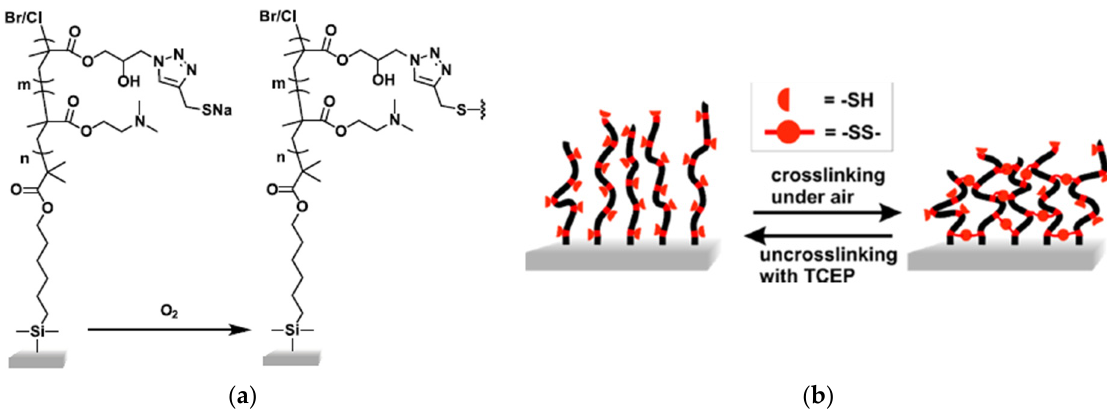
Figure 17. ( a ) Cartoon illustrating the reversible formation of disulfide crosslinks between polymer brush chains. ( b ) The composition of the polymer brushes studied by Mocny et al. Reprinted with permission from [86]. Copyright (2020) American Chemical Society.